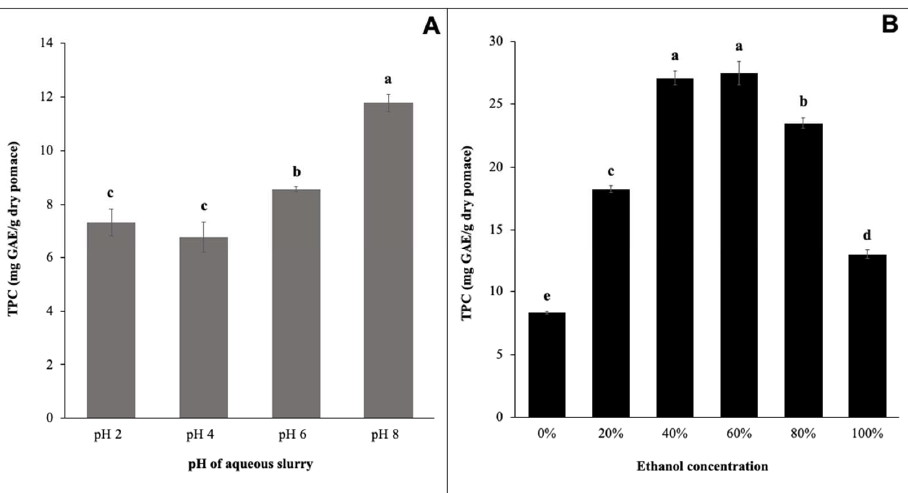
Figure 3. Effects of ( A ) the aqueous slurry pH on the TPC (Folin-Ciocalteu method) of AEP grape pomace extracts and ( B ) ethanol solvent concentration on the TPC of grape pomace extracts produced by conventional solvent extraction. All extractions were conducted using a 1:10 SLR at 50 °C for 90 min. Different letters represent significant differences in TPC ( p < 0.05) across the extraction treatments. Data represent the mean ± one standard deviation of triplicates.